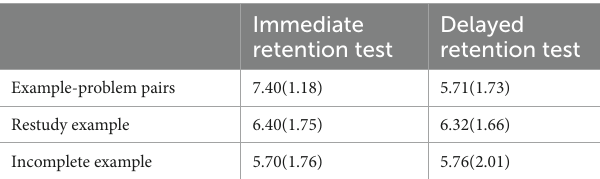
TABLE 2 The mental effort of retrieve practice on problem-solving under different initial test